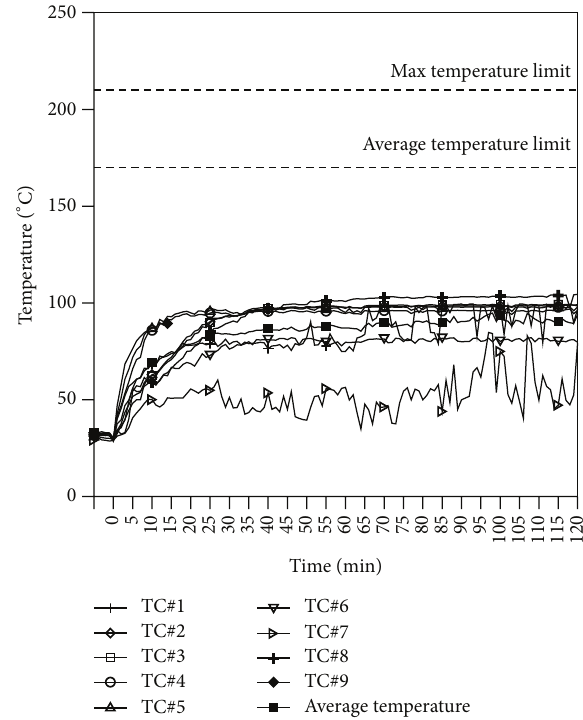
Figure 10: Temperature distributions of the unexposed surface (water film on the unexposed surface).